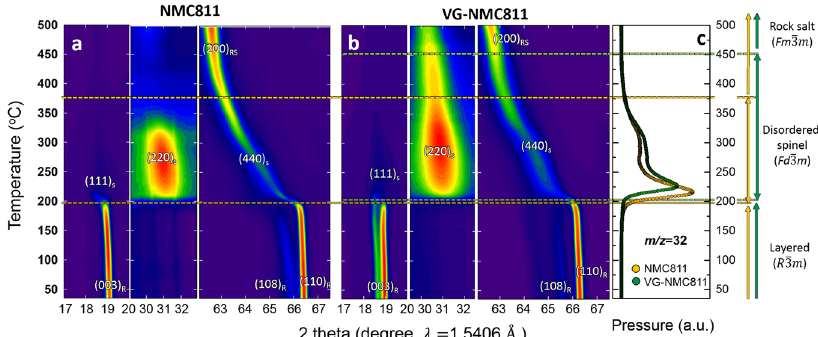
Fig. 4 Time-resolved X-ray diffraction measurements of the cathode materials during thermal abuse tests. Contour plot of the time-resolved X-ray diffraction (TR-XRD) patterns at the selected 2 θ range of the a charged conventional NMC811 and b the valence gradient NMC811 material (VG-NMC811) during in situ heating to 500 °C. c O 2 released from conventional NMC811 and VG-NMC811 during in situ heating to 500